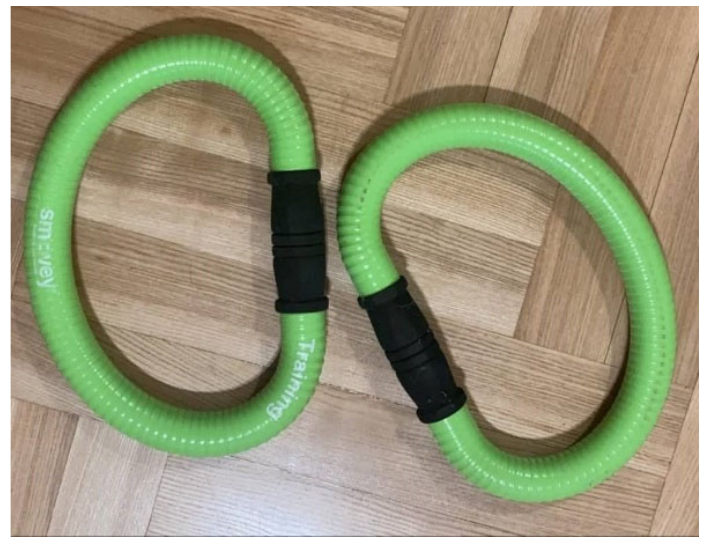
Figure A1. Smovey rings .